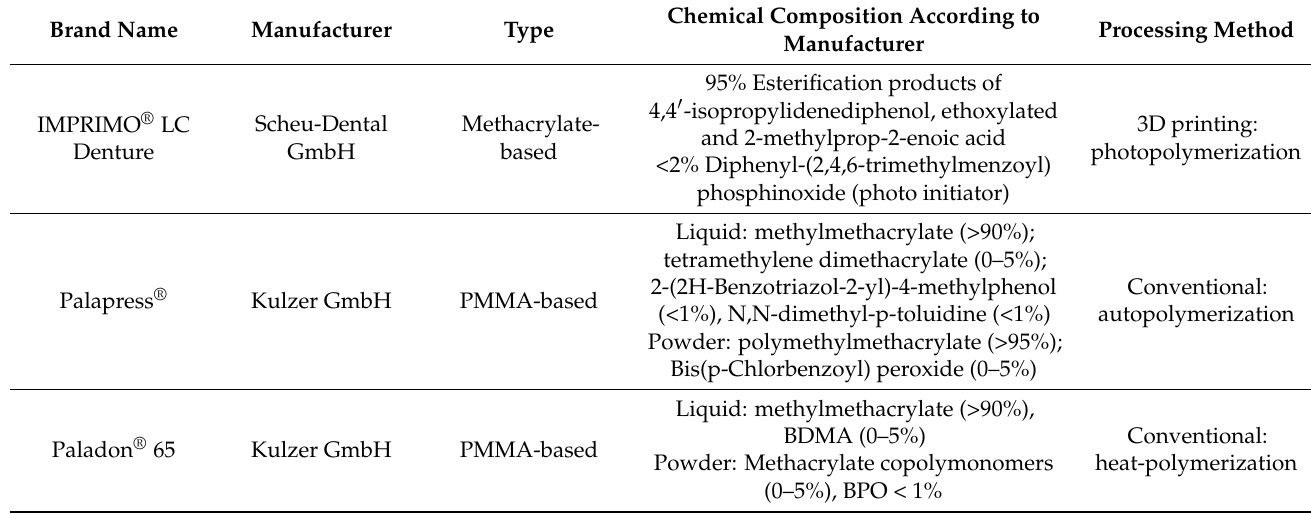
Table 1. Name, manufacturer, type, chemical composition, and processing method of evaluated denture base resin materials.